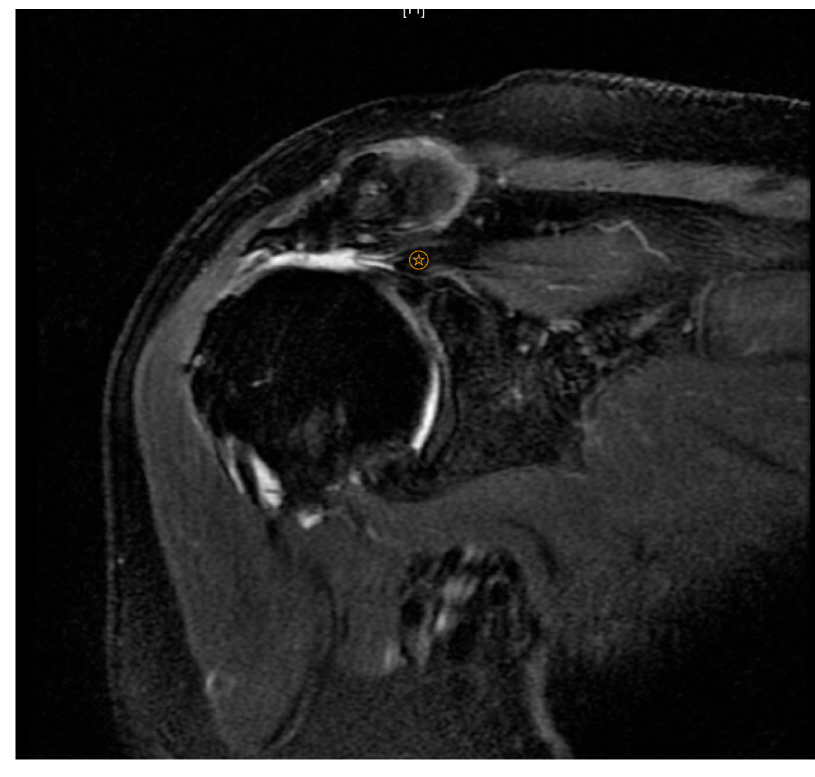
Figure 1. Patte Grade 3. indicates level of supraspinatus tendon retraction.